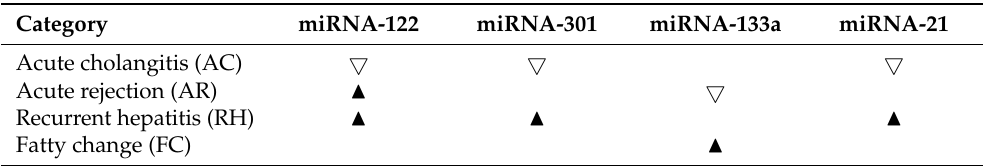
Table 4. Liver graft pathologies and hepatic micro-RNAs expression patterns in acute jaundice after living donor liver